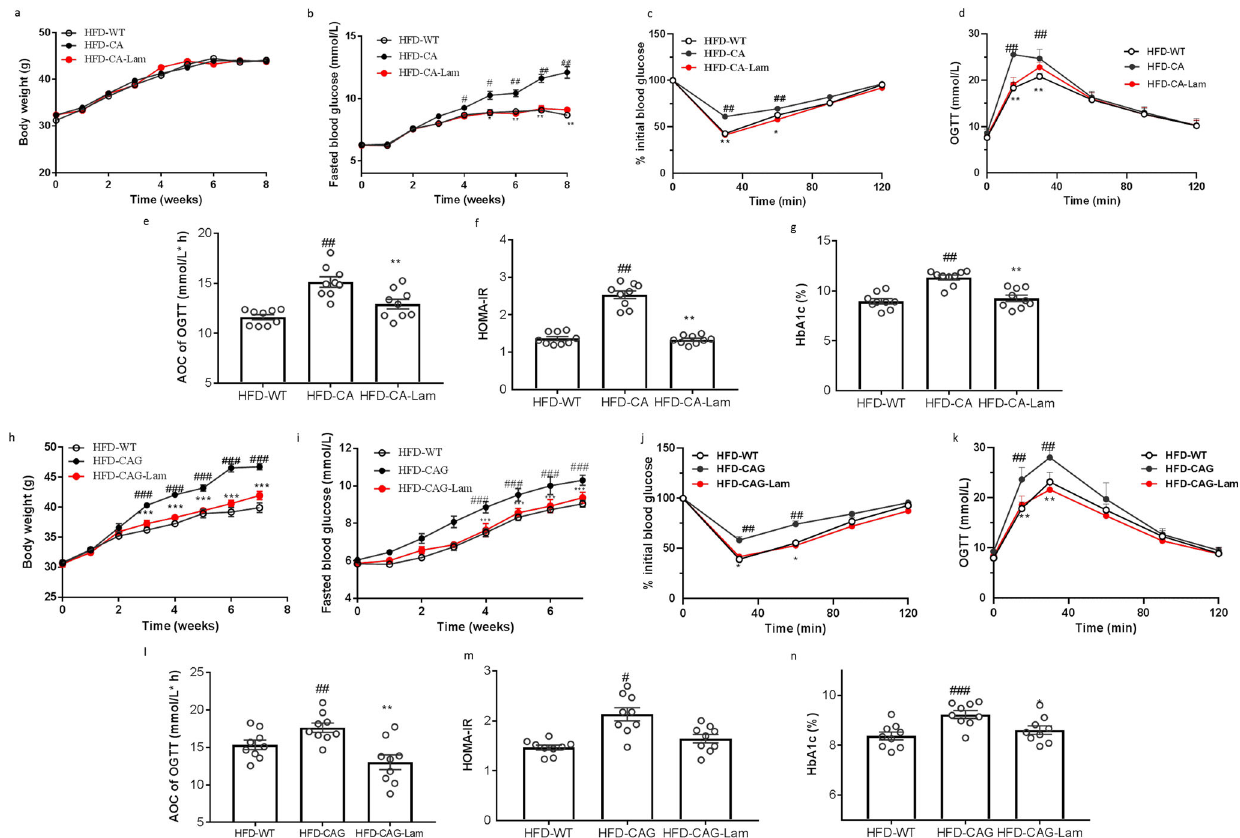
Fig. 7 Dectin-1 Antagonist Laminarin treatment reversed the deteriorated effect of C. albicans and CAG on HFD-treated mice. Effects of Laminarin on C. albicans induced metabolic disorders. a Body Weight, b Fasted blood glucose, c ITT on the 31th day, d OGTT and e AOC on the 34th day, f HOMA-IR, g HbA1c. Effects of Laminarin on CAG induced metabolic disorders. h Body Weight, i Fasted blood glucose, j ITT on the 31th day, k OGTT and l AOC on the 34th day, m HOMA-IR, n HbA1c. Data are presented as the mean ± standard error of the mean (SEM); n = 9 mice per group. Statistical analysis was done using one-way ANOVA followed by the Tukey post hoc test. * P < 0.05; ** P < 0.01 and *** P < 0.001vs HFD-CA (CAG) group, and # P < 0.05; ## P < 0.01 vs HFD-WT